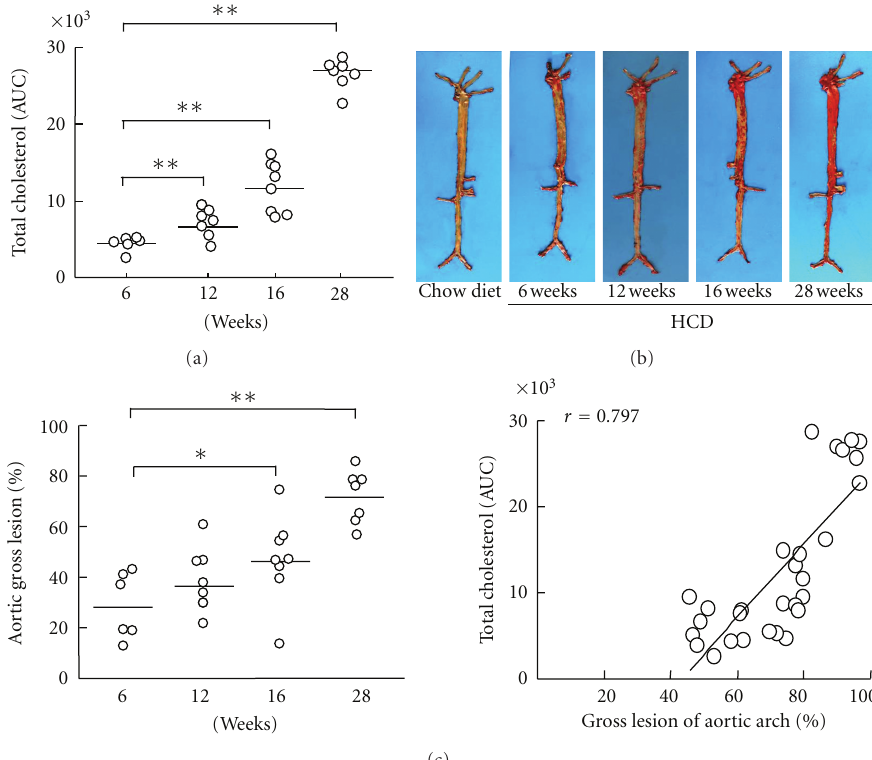
Figure 2: cholesterol exposure and gross atherosclerotic lesions. Cholesterol exposure was evaluated by the area under the curve (AUC) at di ff erent experimental time points (a). Representative images of aortic atherosclerosis as stained by Sudan IV (b). Gross lesion areas (left) that were calculated in the aortas of chow- and HCD-fed rabbits at 6, 12, 16 and 28 weeks and the correlations (right) between cholesterol exposure and gross lesion area (c). The data are expressed as the means ± SEM. n = 6–8 for each group. ∗ P < 0 . 05 and ∗∗ P < 0 .